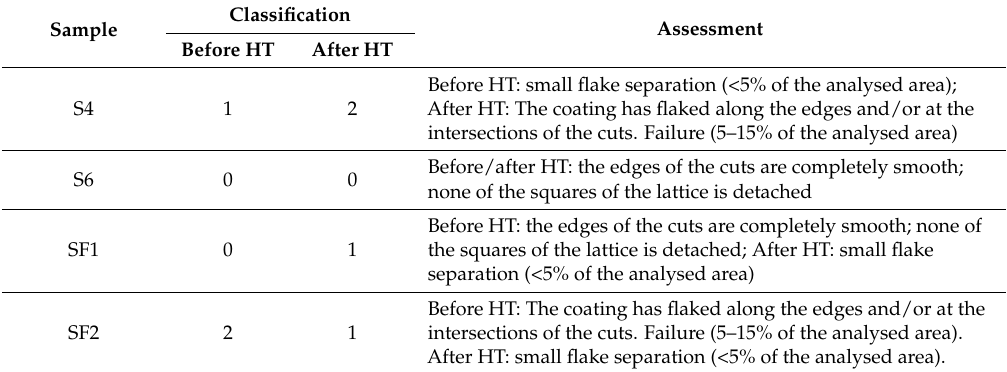
Table 3. Sample classification on adhesion tests (according to ISO 2409:2007 E), before and after heat treatment (HT, 450 ◦ C 12 h;